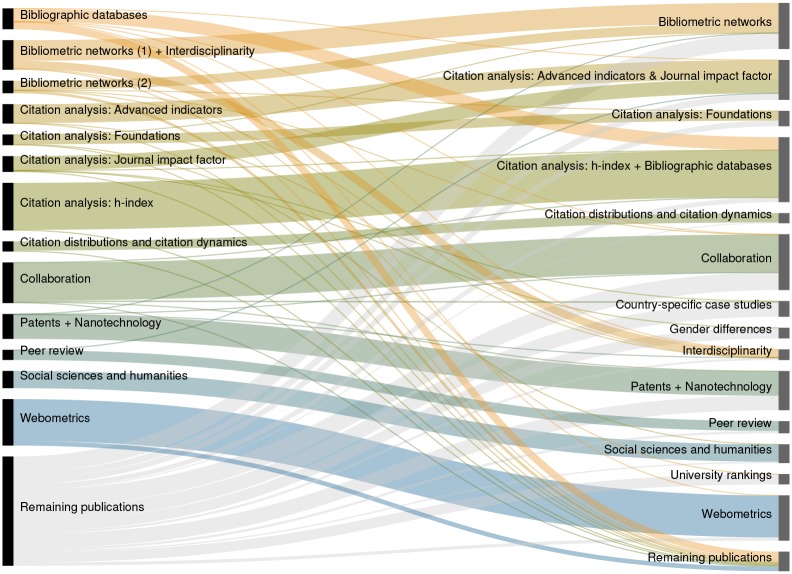
Alluvial diagram of the clusterings obtained by the map equation methods Metimap and Infomap.The diagram shows the overlap between the largest scientometric clusters returned by Metimap and Infomap on the Library & Information Science citation network (left and right, respectively). ‘Remaining publications’ are included in one of the clusters in the Metimap (Infomap) clustering but not included in any of the clusters in the Infomap (Metimap) clustering. See Table 5 for details of the clusterings.